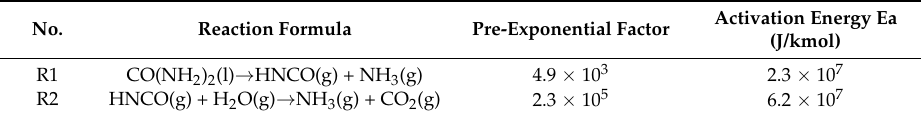
Table 3. SCR reaction pathway and reaction rate.